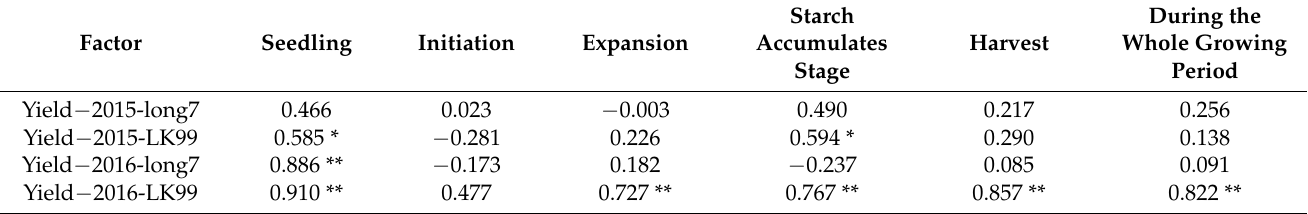
Table 4. Correlation Analysis between Yield and Soil-Moisture Content.